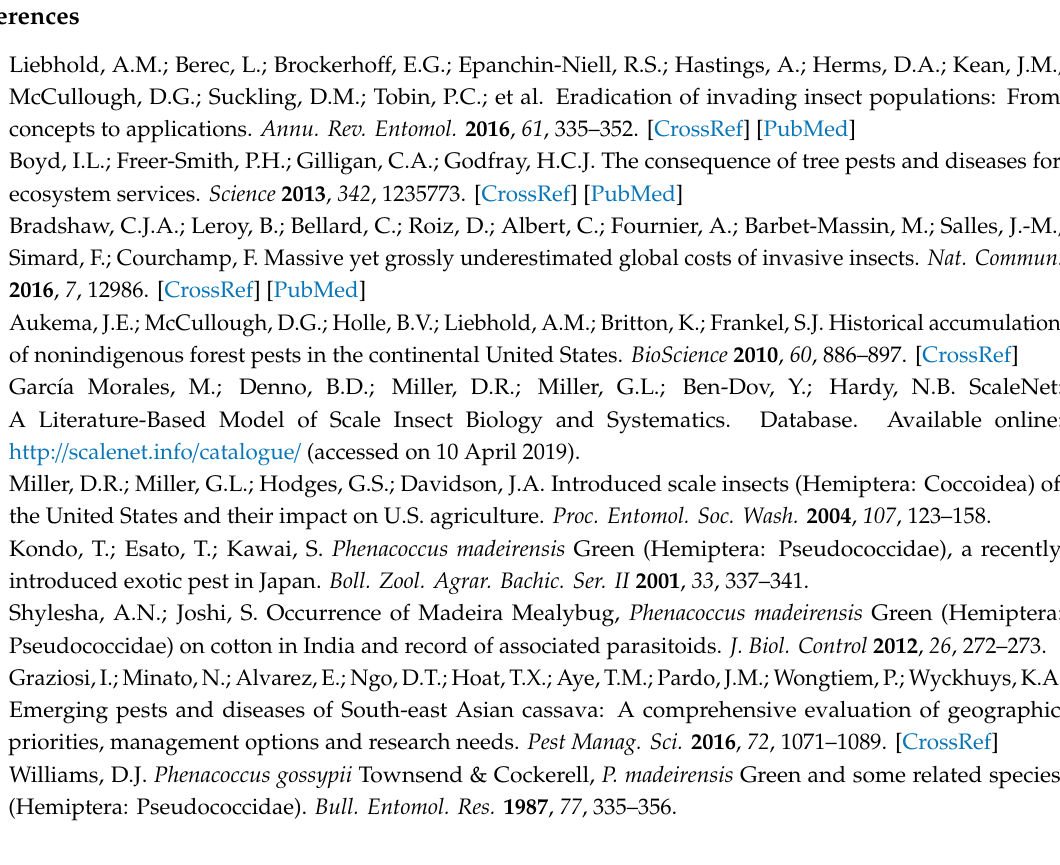
Figure S1: Performances of niche model of pest. L = Linear; Q = Quadratic; H = Hinge; P = Product; T = Threshold, Figure S2: Partial AUC Values and Graphics, null model (red distribution), distribution of expectations created via bootstrapping replacement of 50% of the total available points and 1000 resampling replicates (blue distritbuion), Table S1: References used to compile the dataset, Table S2: Distribution sites for P. madeirensis , Table S3: Correlation analysis of environmental variables for P. madeirensis , Table S4: ENMeval results for P. madeirensis from